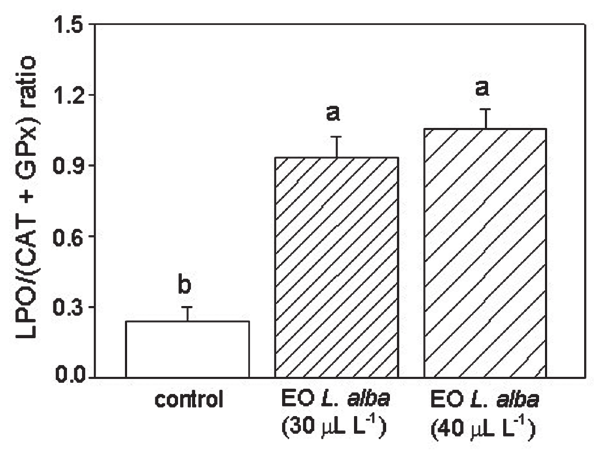
Fig. 4. LPO/CAT+GPx ratio in the liver of silver catfish ( Rhamdia quelen ) transported in plastic bags containing water treated with the essential oil from Lippia alba . The values are expressed as the means ± SEM. Different letters indicate levels of significance between the treatments